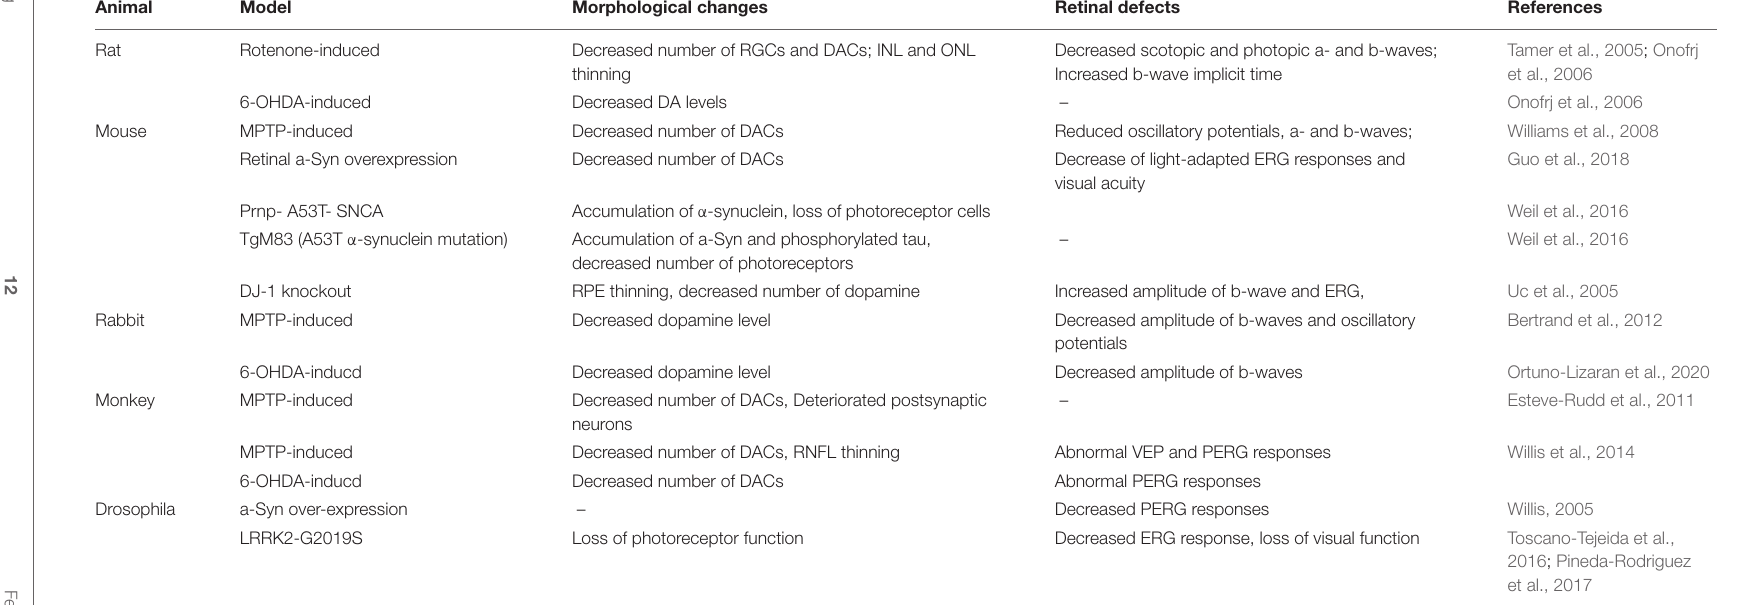
TABLE 4 | Retinal abnormalities in PD animal models.